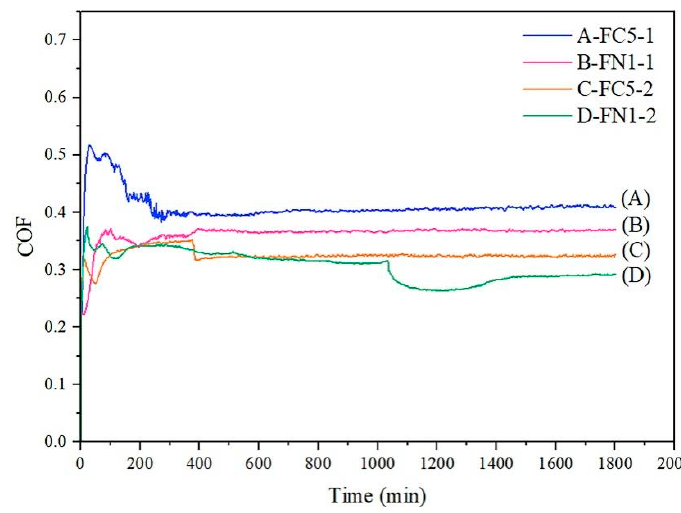
Figure 5. The friction testing curves for both FGCs and conventional carbides.